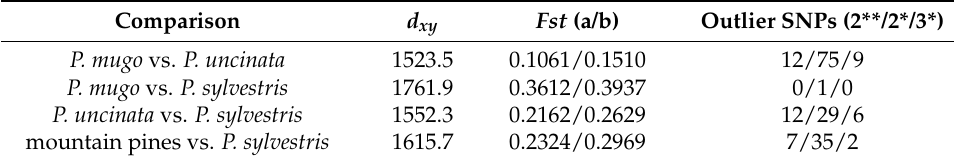
Table 2. Genetic distance and differentiation between the three investigated pine species.